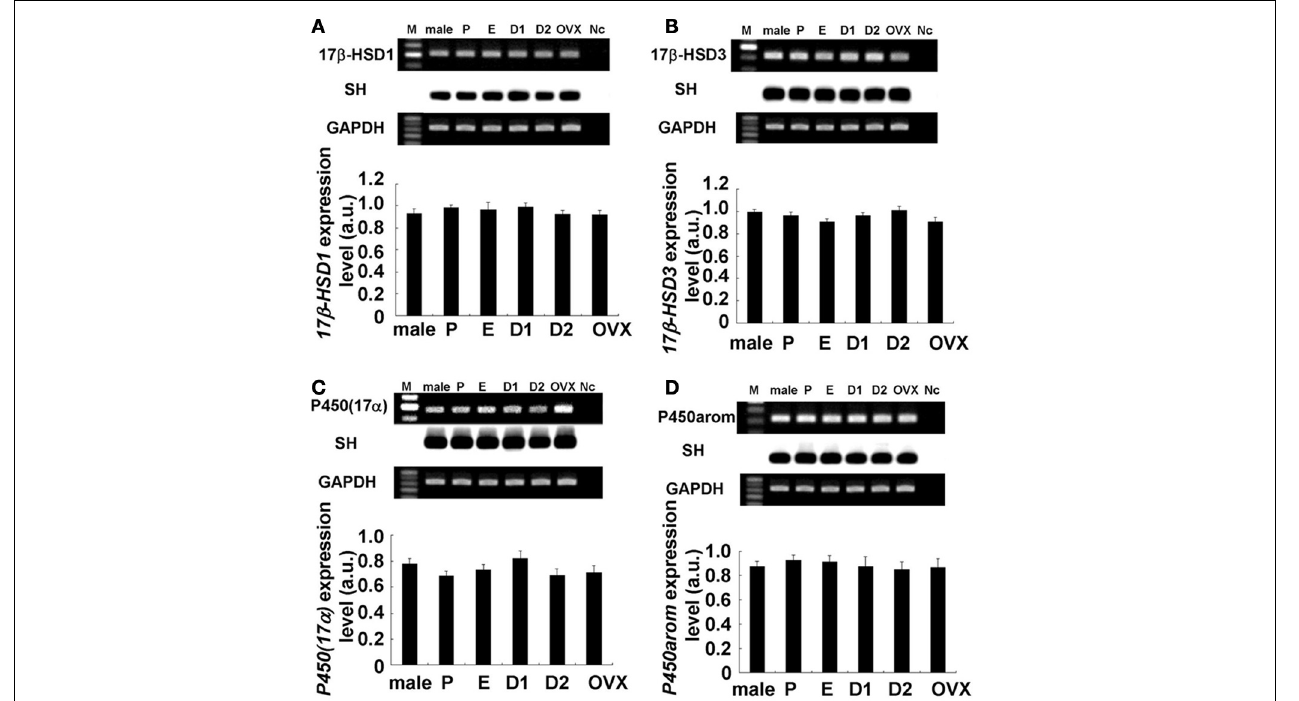
FIGURE 3 | No significant change in expression levels of mRNAs for sex steroidogenic enzymes [A: 17 β -HSD1, B: 17 β -HSD3, C: P450(17 α ), and D: P450arom] in the female hippocampus across the estrus cycle. Upper panels show representative PCR images and lower panels show statistical comparisons. In each images, from left to right, size marker (100bp ladder) (M), male hippocampus (male), female hippocampus at Pro (P), Est (E), D1 (D1), D2 (D2), and OVX female rats (OVX), the sample without template DNA as negative control (Nc). For each enzyme, the RT–PCR products for mRNAs are visualized with ethidium bromide staining on the top of each panel.